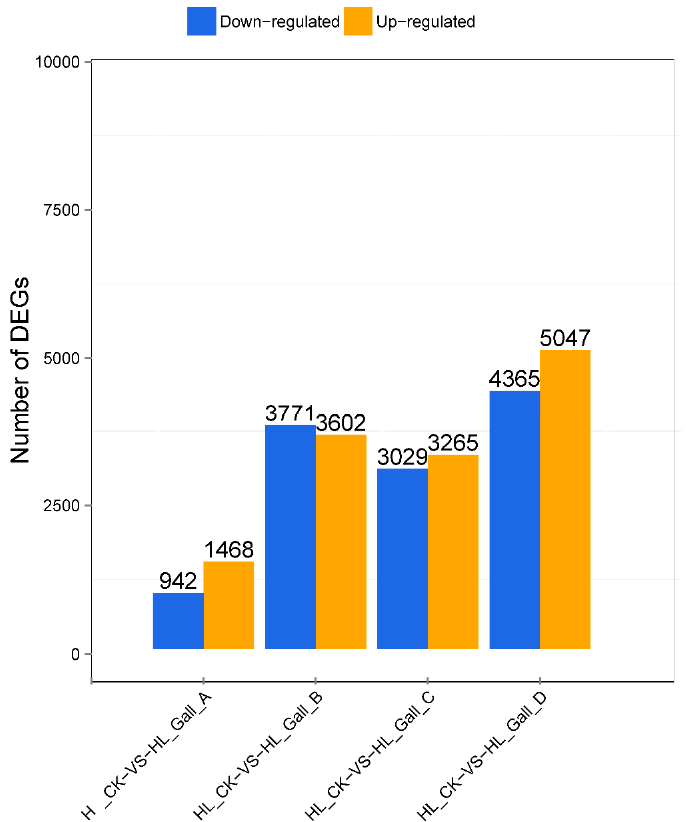
Figure 2. Number of differentially expressed genes during different gall-formation stages.